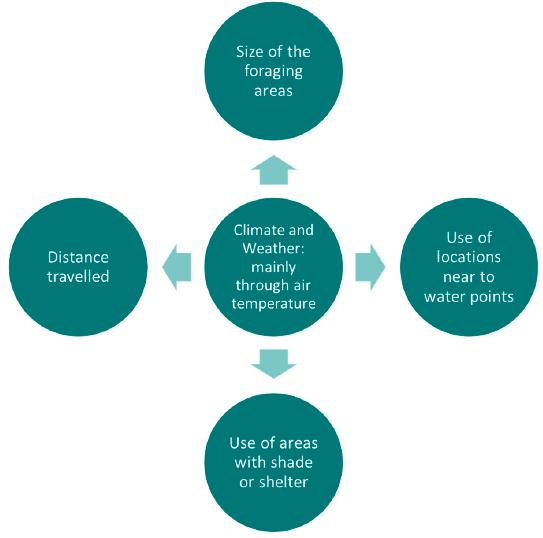
Figure 8. Summary diagram of the main variables of site use preference being affected by climate and weather conditions.